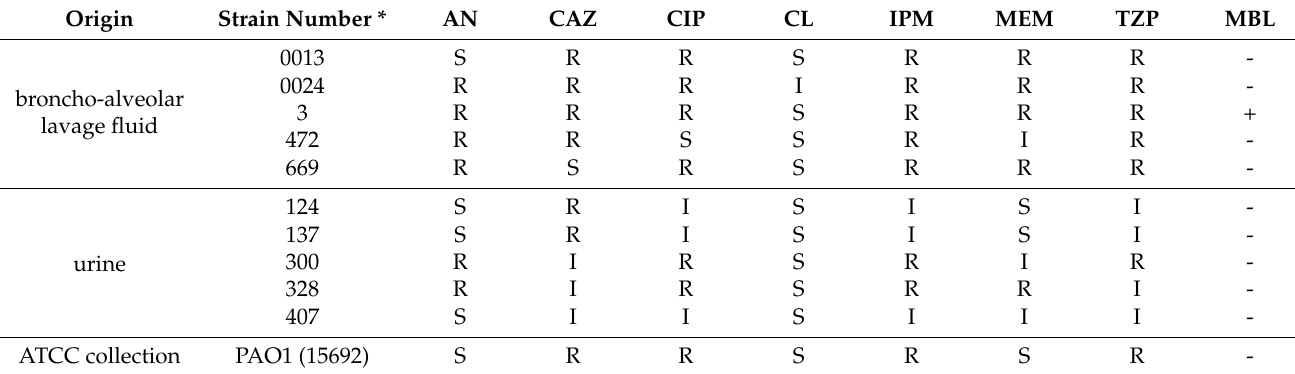
Table 2. Antibiotics’ susceptibility of P. aeruginosa strains.